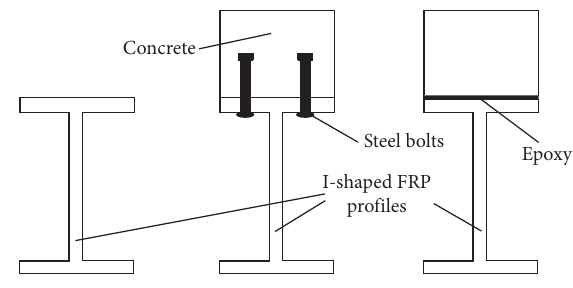
Figure 23: Connection technologies between FRP profiles and concrete studied by